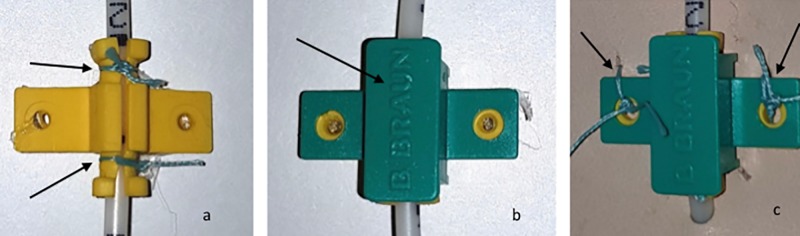
Steps of the “compression” technique.A)Two sutures are placed at the inner soft part of the clamp to increase compression of the soft part and to increase friction between the soft part of the clamp and the catheter. B) The outer rigid part of the clamp is placed on top of the soft part. C) The clamp is sutured to the leather.